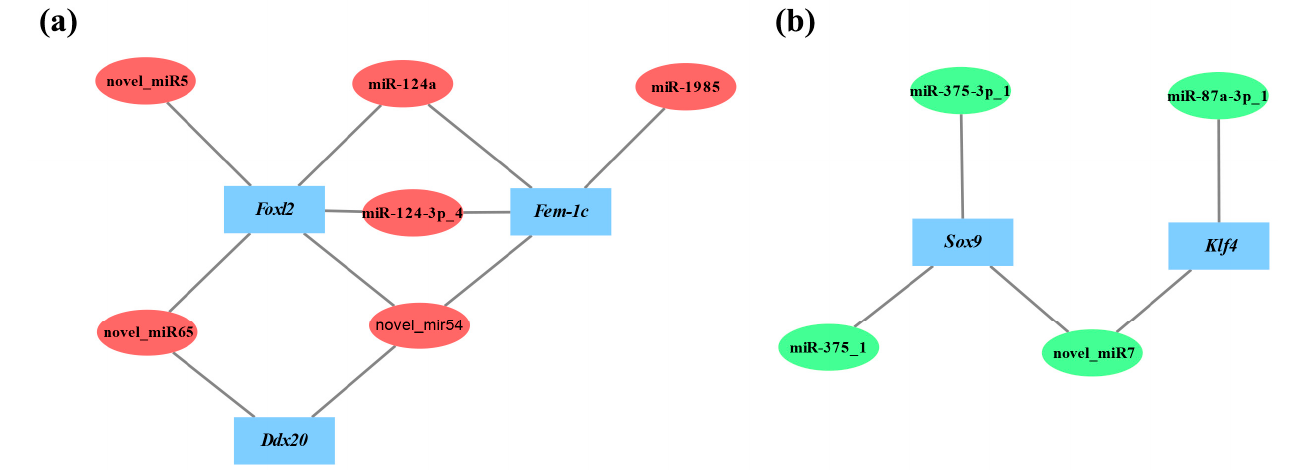
Figure 8. The interacting relationship between sex-related genes and DEMs. ( a ) The interactions between female-related target genes and testis-biased miRNAs. Blue rectangle, miRNA target genes. Red ellipses, testis-biased miRNAs. ( b ) The interactions between male-related target genes and ovary-biased miRNAs. Blue rectangle, miRNA target genes. Green ellipses, ovary-biased miRNAs.